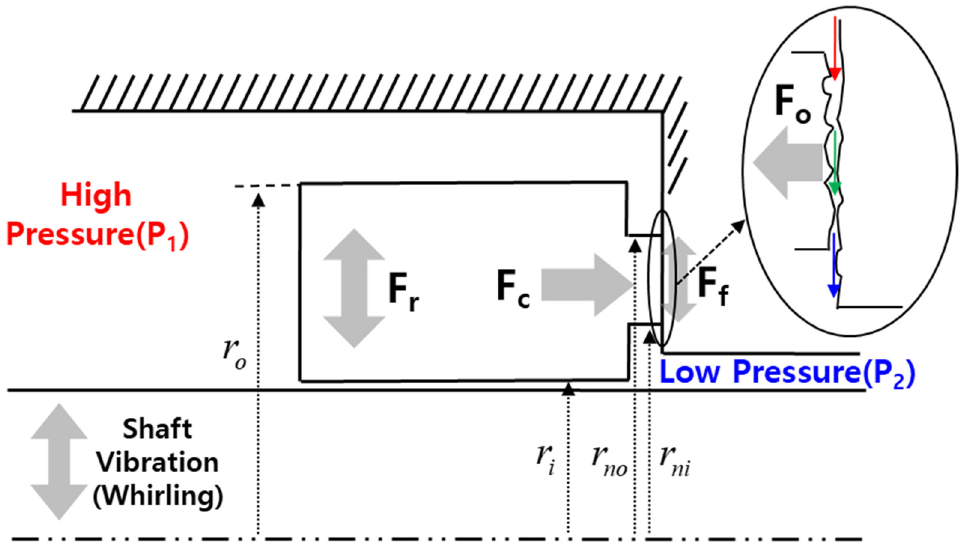
Figure 3. Acting forces on simplified floating ring seal.